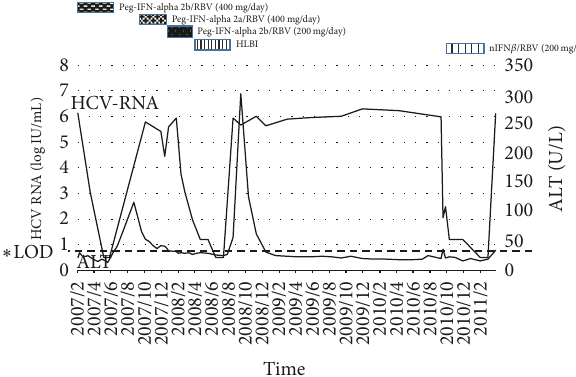
Figure 2: Clinical course of patient (ALT and HCV RNA). ∗ Limit of detection (LOD).